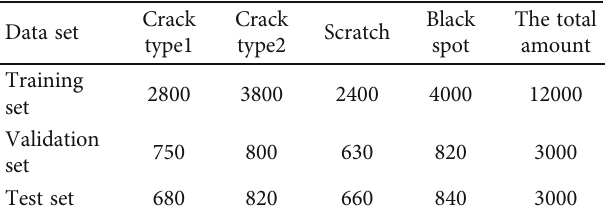
Figure 12: Part of the data set after data augment. Table 3: Sorting out the image data